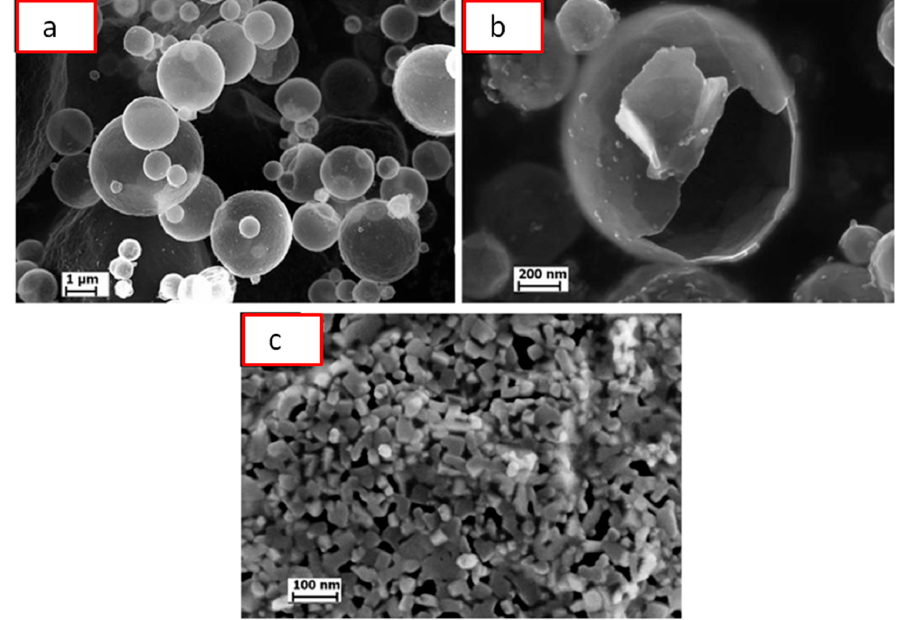
Figure 10. Morphology ( a , b ) and wall structure ( c ) of hollow Ni particles obtained by spray solution combustion synthesis. Reprinted from Trusov et al. [22], Copyright (2018), with permission from Elsevier.